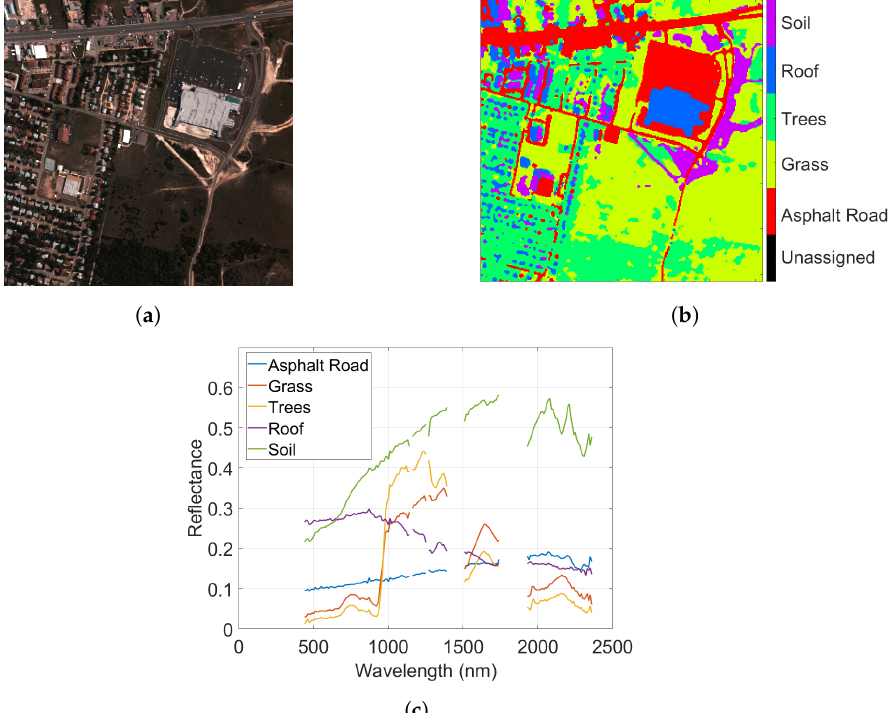
Figure 11. HYDICE Urban Image: ( a ) true-color composite; ( b ) reference data classification map [42]; ( c )